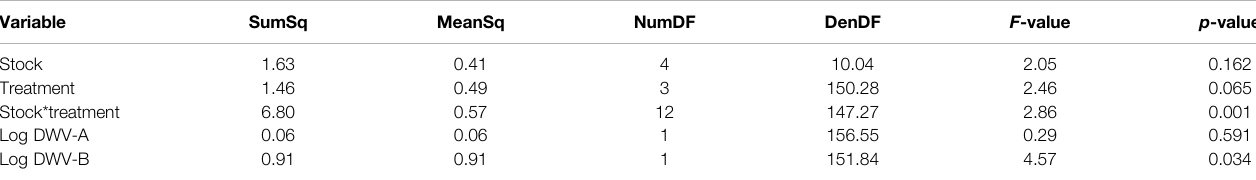
TABLE6| DWVsymptompresencelogit.Binomiallogisticregression fi xedeffects for the presence of any DWV symptoms (wing deformities). All viral data were collected from head tissues (N = 180 bees and N = 180 RNA extractions in